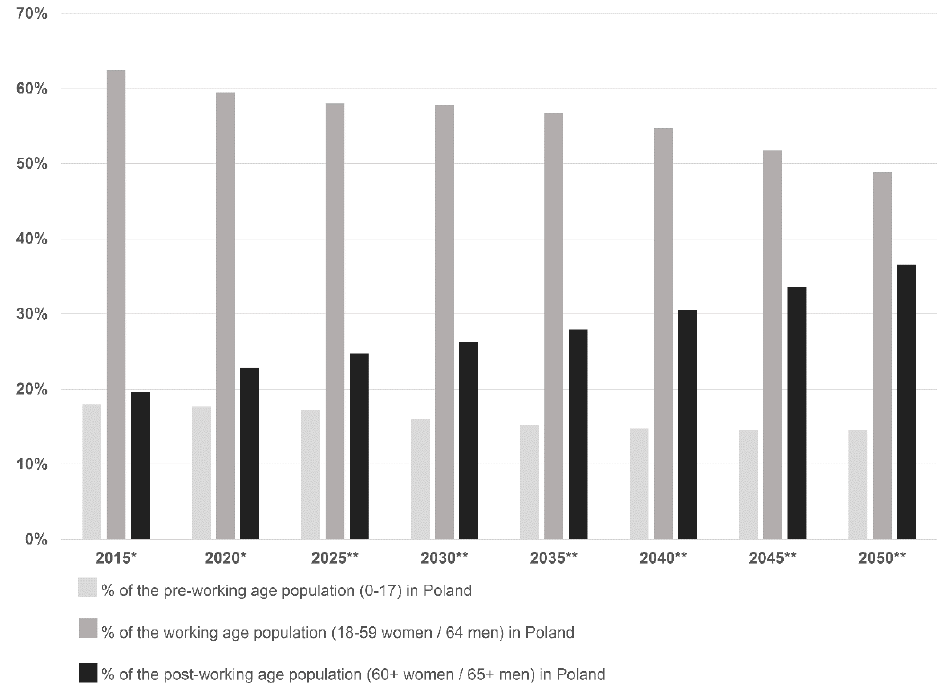
Figure 1. Population structure in Poland: current (*) and forecast state (**) 2050. Based on the data of the Central Statistical Office: A. Skórka. *, http://demografia.stat.gov.pl/bazademografia/Tables.aspx; **, https://stat.gov.pl/obszary-tematyczne/ludnosc/prognoza-ludnosci/prognoza-ludnosci-na-lata-2014-2050-opracowana-2014-r-,1,5.html (assessed on 20 April 2021).